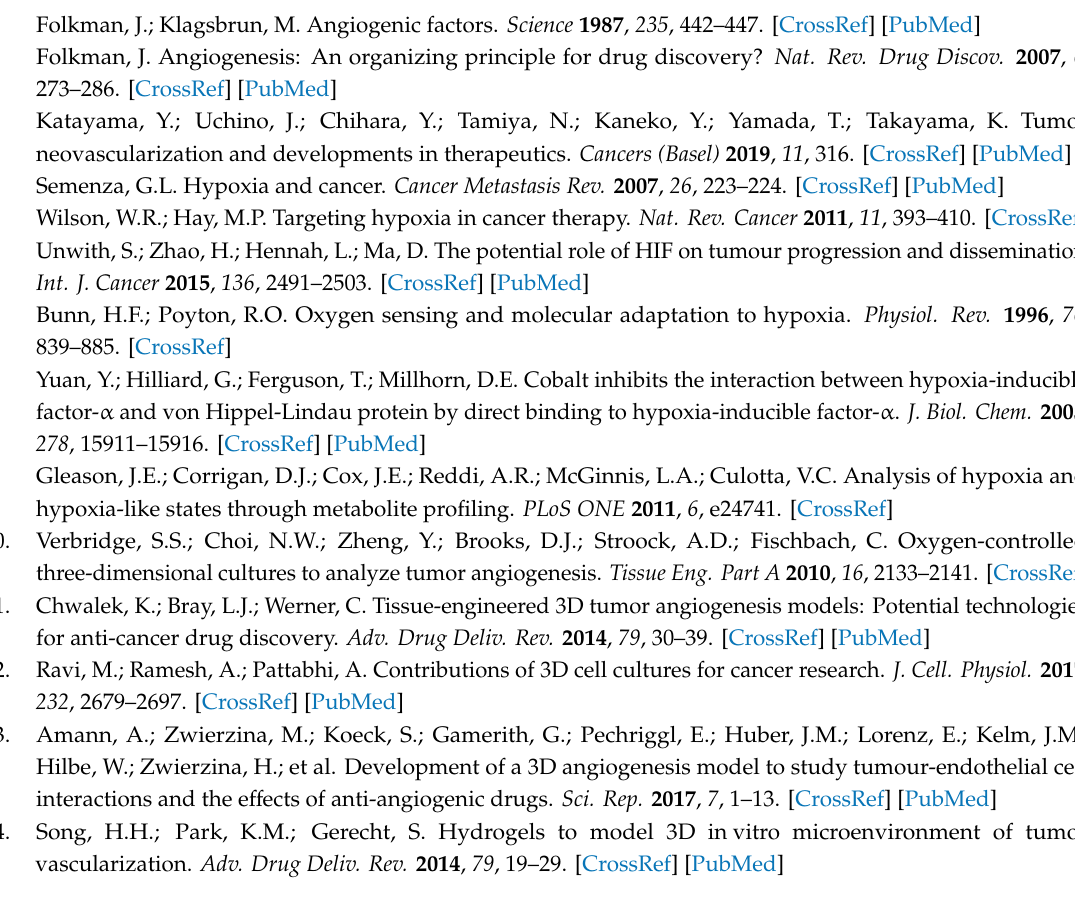
independent experiments. Data are presented as mean ± SD values ( n = 3). * p < 0.05, compared to cultures without VEGF. Supplementary Figure S3. ZO-1 expression in EA.hy926 ECs cultured on a culture plate and nanofibrous membrane sca ff old. EA.hy926 ECs (3 × 10 4 ) were cultured for 5 d on a culture plate ( A ) and C / DMF-PCL-M or C-PCL-M in the presence ( + VEGF) or absence ( − VEGF) of VEGF ( B ). The formation of tight junctions between the cells (arrows) was evaluated using confocal microscopy after the cells were stained using anti-ZO-1 antibody (red). The data represent three independent experiments. Supplementary Figure S4. VEGF production by CT26 and HepG2 cells cultured on the nanofibrous membrane. CT26 ( A ) and HepG2 ( B ) cells (3 × 10 4 ) were cultured for the indicated periods on an 8-well culture plate (Culture plate) and C-PCL-M attached to an 8-well plate (C-PCL-M). VEGF concentrations were measured via ELISA. Data are presented as mean ± SD values ( n = 3).* p < 0.05, compared to cultures at d 1; ** p < 0.05, compared to cultures at d 3. Supplementary Figure S5. E ff ects of CoCl 2 on the growth and proliferation rate of CT26 cancer cells cultured on the culture plate and nanofibrous membrane. CT26 cells were cultured on an 8-well plate (2D) and C-PCL-M attached to 8-well plates (3D) for the indicated periods with or without 150 µ M CoCl 2 . ( A ) Cell distributions and morphology were analyzed via confocal microscopy. ( B ) The proliferation rate of the cells was analyzed using a CCK-8 assay. Images represent three independent experiments. Data are presented as mean ± SD values ( n = 3). * p < 0.05, compared to cultures without CoCl 2